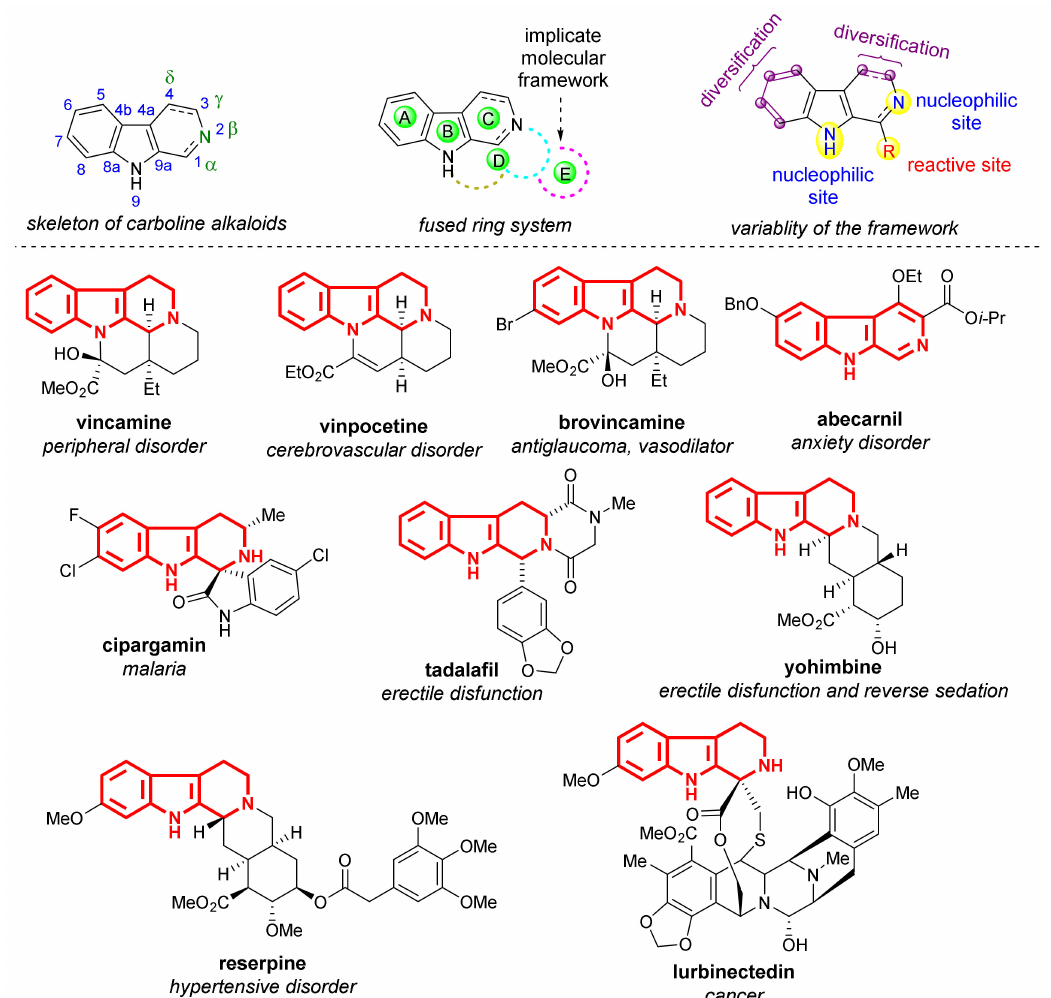
Figure 1. Structure of carboline skeleton and drugs containing a β -carboline